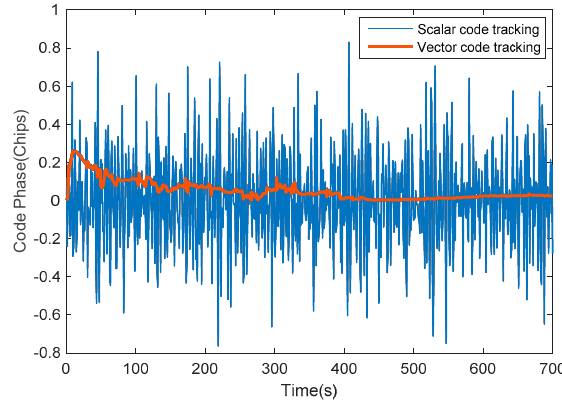
Figure 9. Comparison between scalar and the vector code tracking in the integrated system.